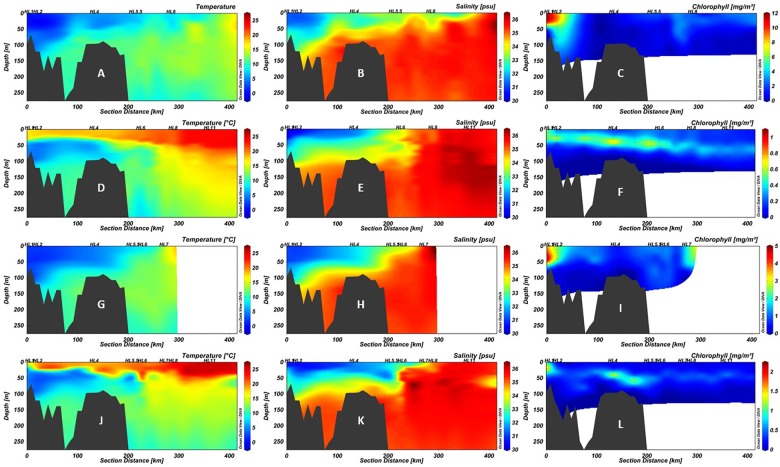
Section plots of the Halifax Line (HL) in 2014 spring (A–C), 2014 fall (D–F), 2016 spring (G–I), and 2016 fall (J–L). The first column (A,D,G,J) shows temperature (°C), the second (B,E,H,K) salinity (psu), and the third (C,F,I,L) chlorophyll a (mg/m3). Note that while color scales for temperature and salinity are consistent between panels, those for chlorophyll a differ due to high variability between cruises. Points indicate locations of data collection; black polygons are bottom contour (GEBCO 2014 6 × 6 min). Stations sampled in this study are labeled above the plots. The 200 km point represents the average location of the Shelf-Slope Front (SSF).